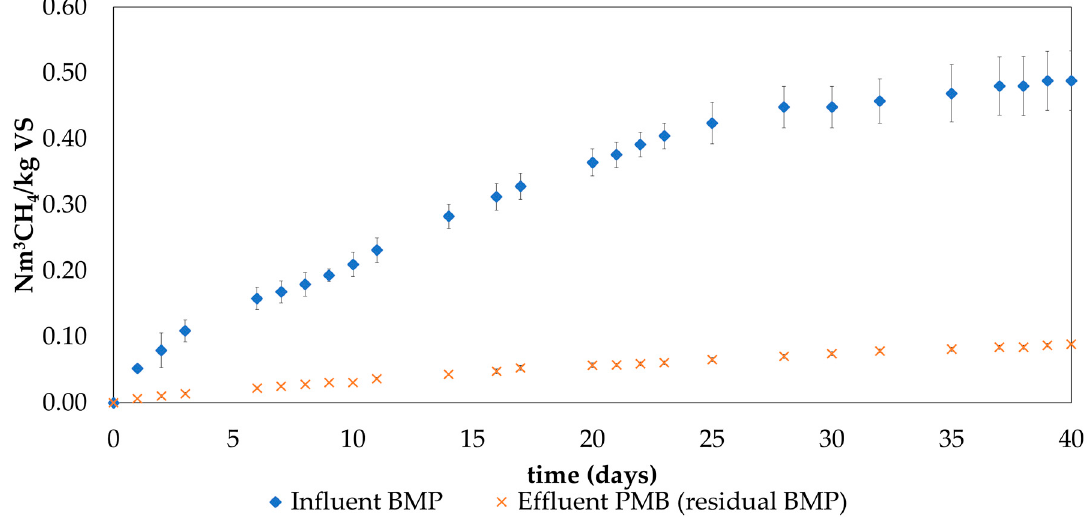
Figure 8. Influent (blue rhombus) and effluent (orange cruxes) biomethane potential kinetic.